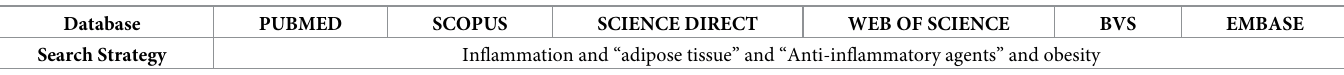
Table 1. Research strategy equation to search for articles in databases to answer the question: What are the action mechanisms of anti-inflammatory agents in adi- pose tissue?. Database PUBMED Search Strategy Inflammation and “adipose tissue” and “Anti-inflammatory agents” and